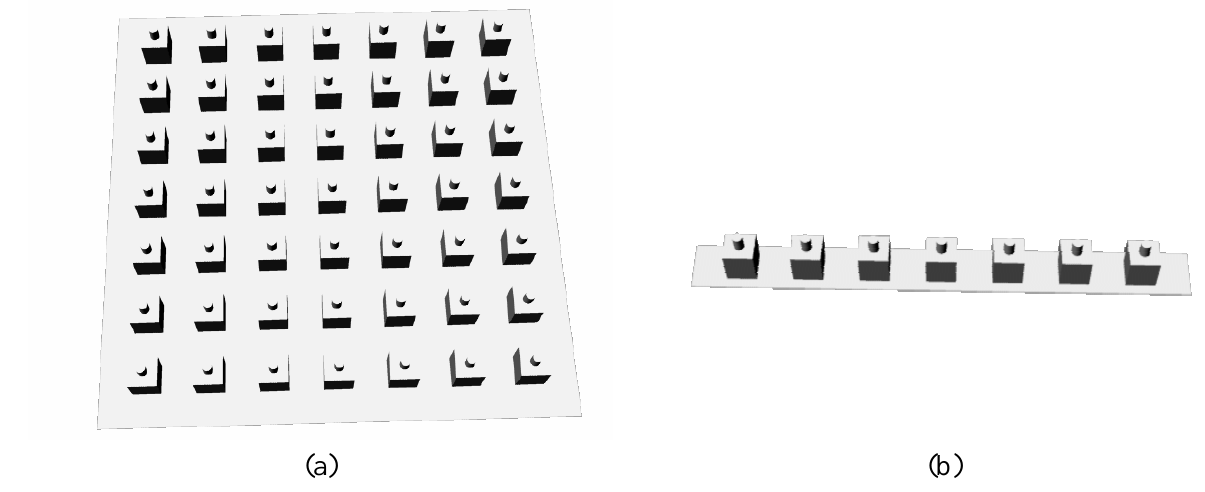
Figure 1. (a) The planar compound-like eye, ( b) The single-row planar compound-like